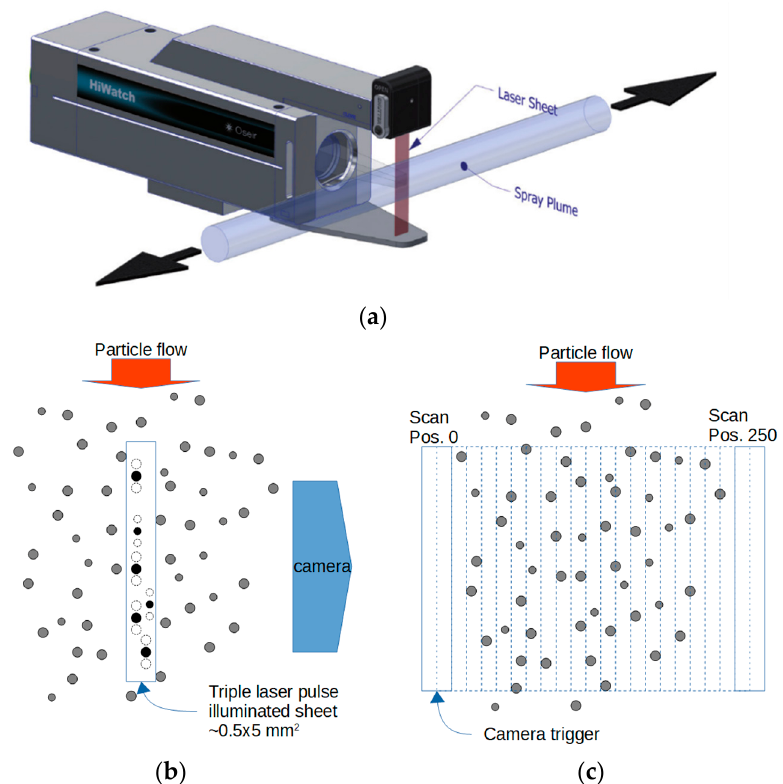
Figure 2. Online spray monitoring ( a ) HW CS2 system, ( b ) particle imaging geometry, and ( c ) scanning plume for 2D mapping.